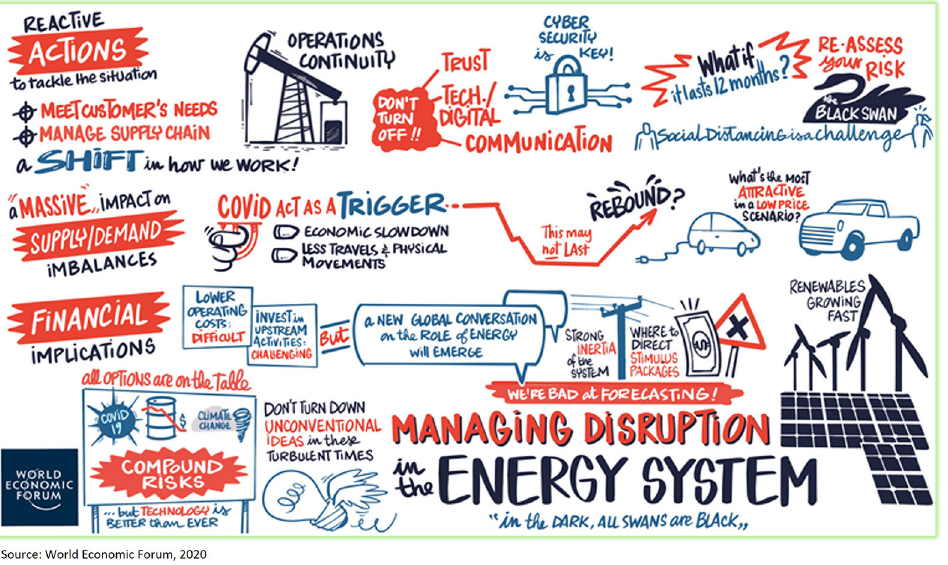
Fig. 25. – How are our energy systems changing today? How should we respond? (Source: World Economic Forum,